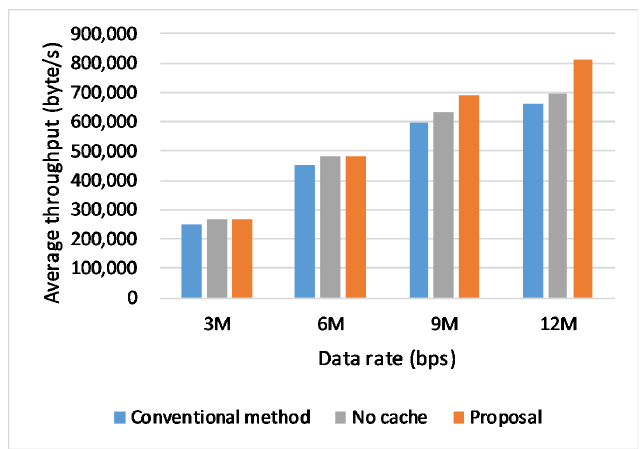
Figure 5. Throughput in different data rates.